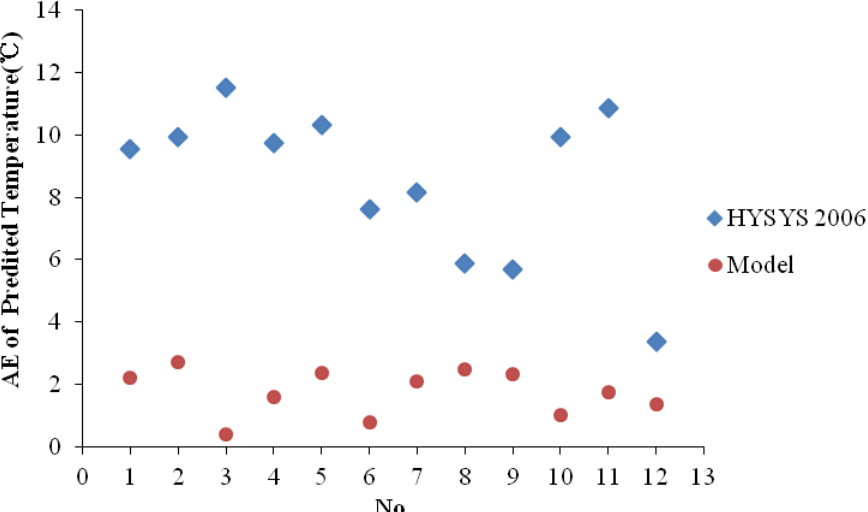
Figure 3. Absolute errors of temperautres between HYSYS and the prediction model with the combination mixing